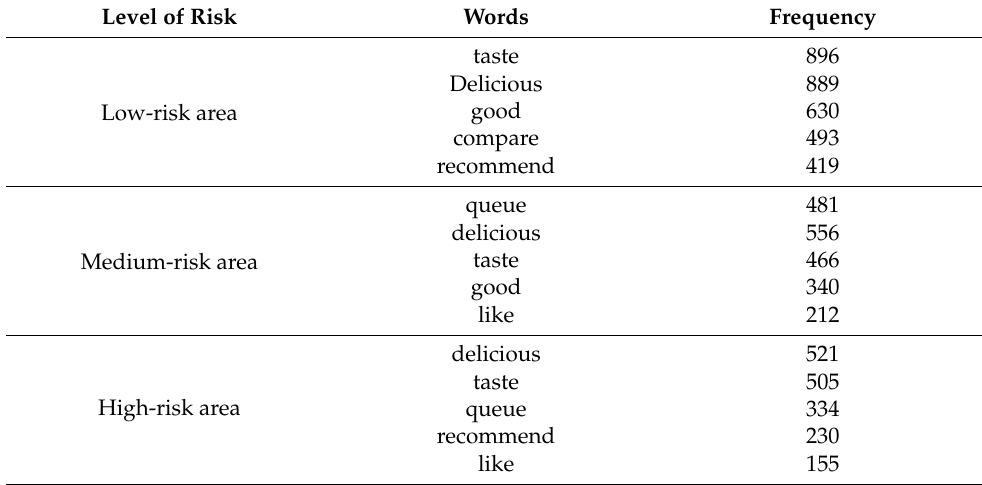
Table 4. Distribution of words before COVID-19.